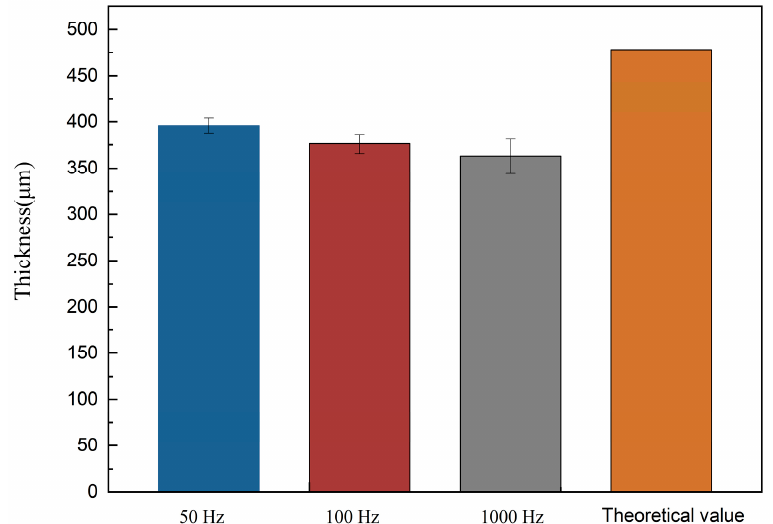
Figure 2. The theoretical and real thickness of electroformed zinc.